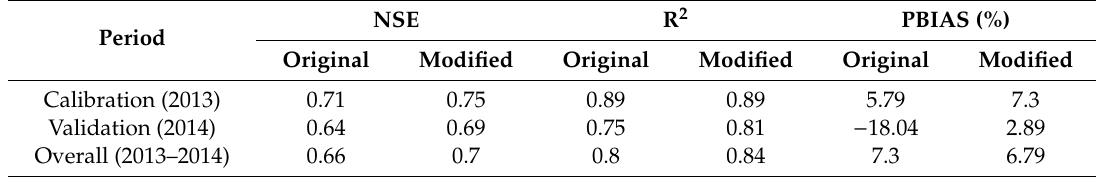
Table 3. The results of daily calibration and validation for TRB, Kunlun Mountains, West